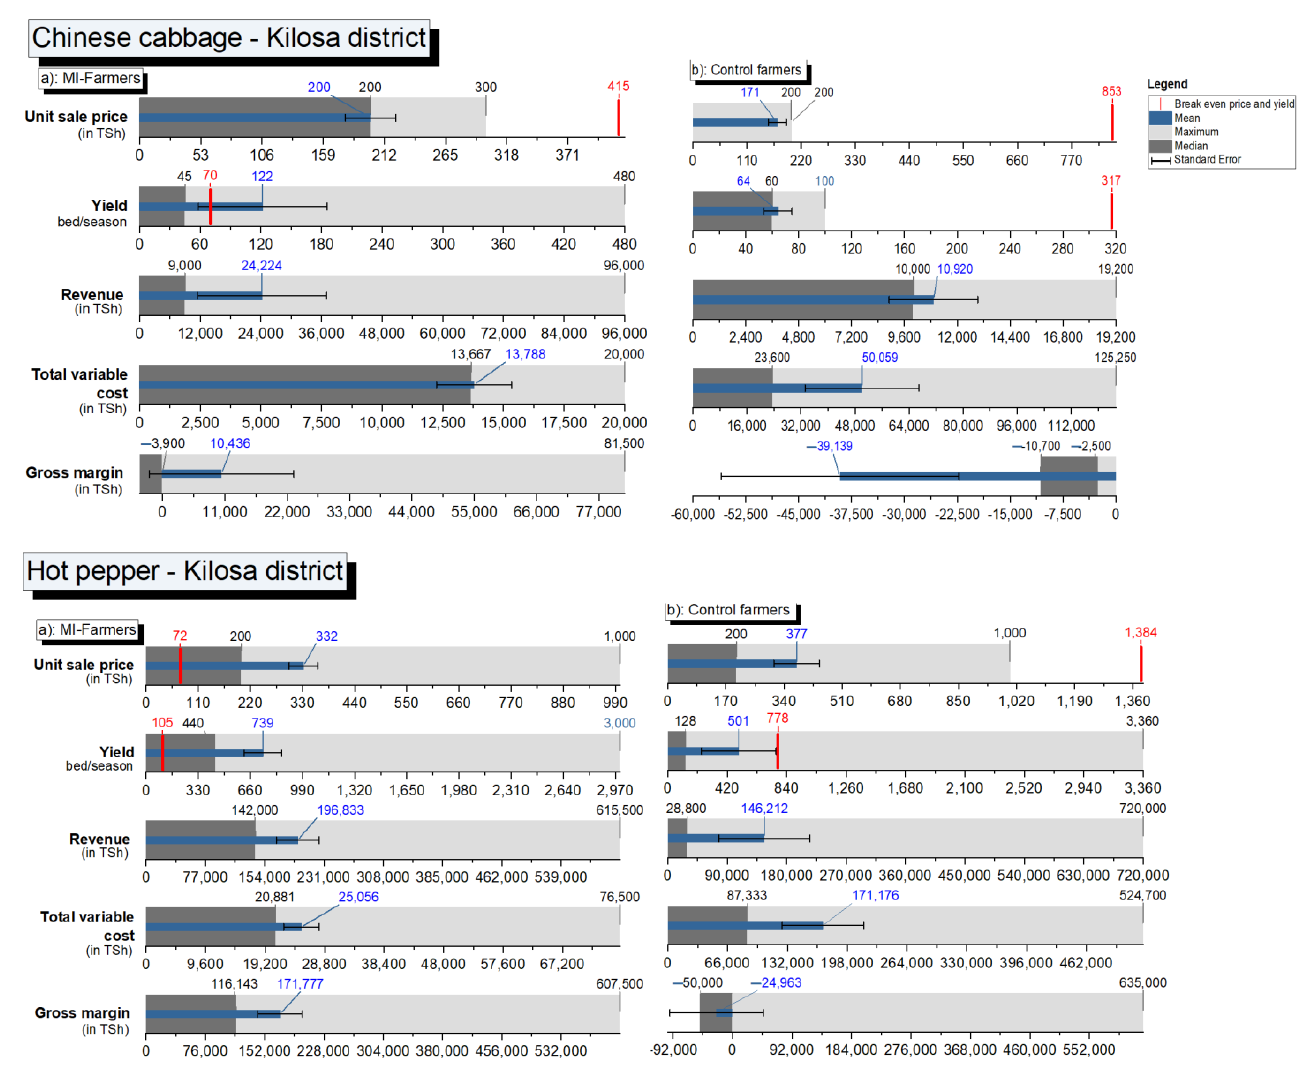
Figure 7. Enterprise comparison of MI farmers ( a ) and control farmers ( b ) growing Chinese cabbage and hot peppers in the Kilosa district. Price, revenue, total variable cost (TVC), and gross margin (GM) amounts are presented in Tanzanian Shilling (TSh), where 1 USD = 2330 TSh and 1 TSh = 0.00043 USD. Yield is calculated as per bed per season. Standard error of mean is presented as error bars for each bar graph.